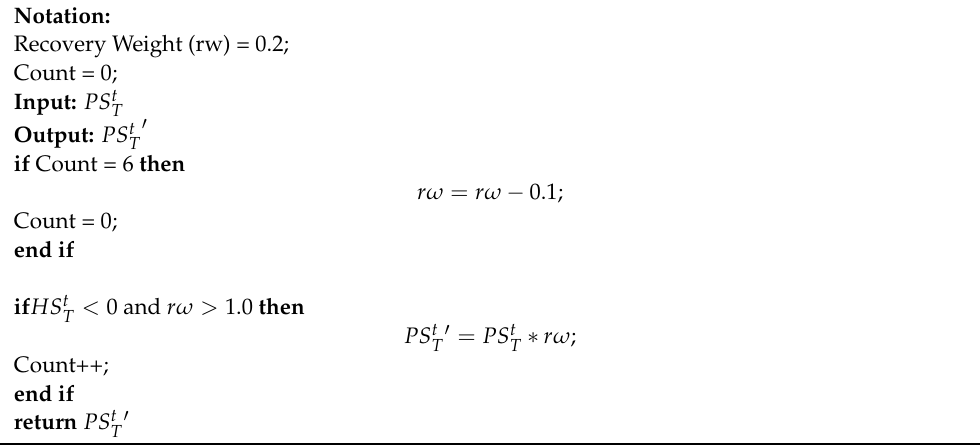
Algorithm 2: Event Weighting Algorithm (Recovery Section)